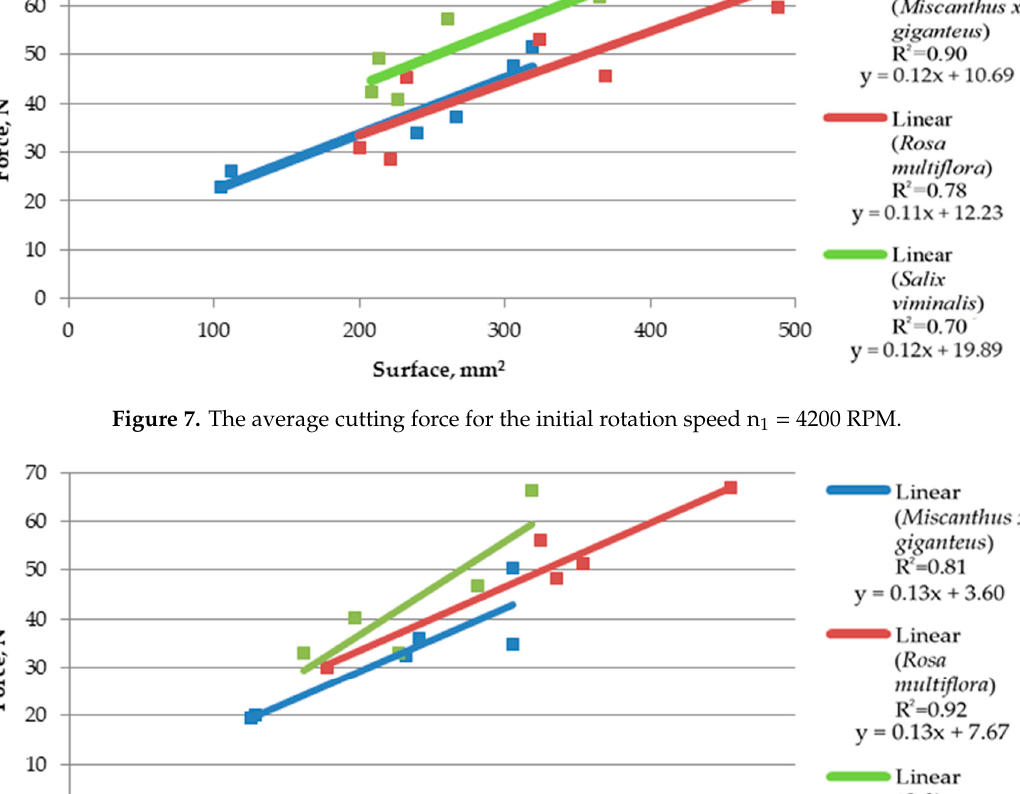
Figure 10. The dependence of the rotation speed vs. torque for Rosa multiflora . Figure 11. The dependence of the rotation speed vs. torque for Salix viminalis .